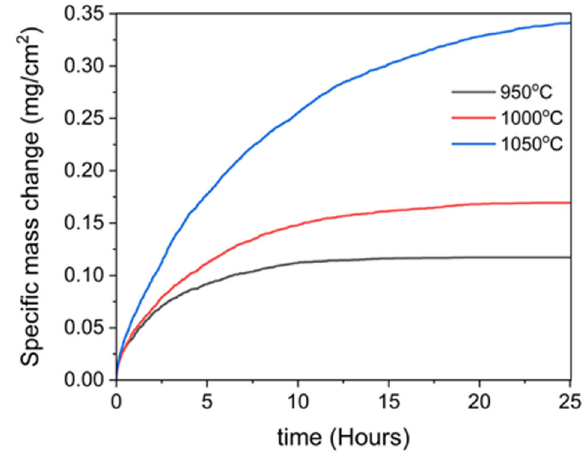
Fig. 5 Effect of temperature on oxidation kinetics as obtained from the CA model. The speci fi c mass change is highest at 1050 °C, describing an exponential increase in oxidation kinetics with the increase in